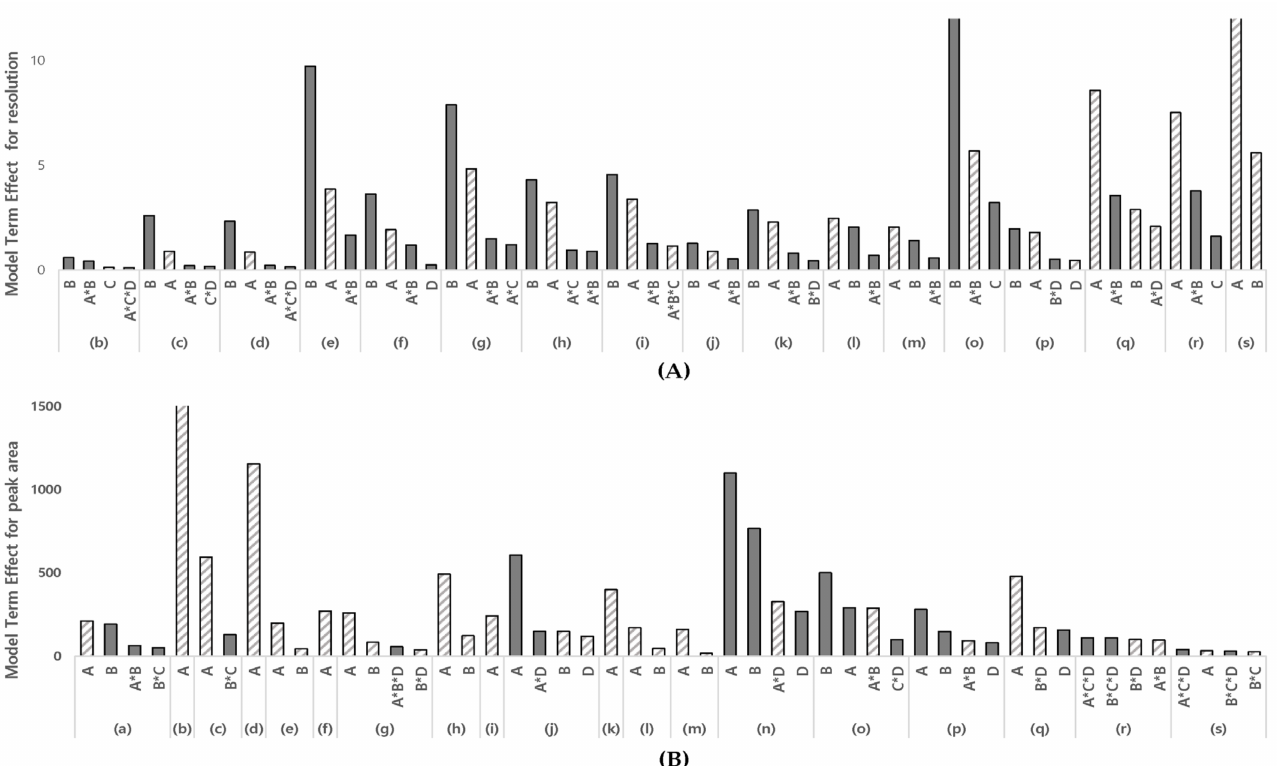
Figure 3. Model terms ranking the Pareto charts, depicting the influences of the initial oven temp., the flow rate of the carrier gas, the oven temp. ramping rate, and the sample injector temp. ( A ) Pareto chart for resolution; ( B ) Pareto chart for peak area; ( A ) initial oven temp., ( B ) the flow rate of the carrier, C oven temp. ramping rate D sample injector temp; (a) VB, (b) 2C1P, (c) 2CP, (d) BE, (e) 2BP, (f) 3C2M1P, (g) 12DCE, (h) 2BB, (i) 12DCP, (j) 4B1B, (k) 1BB, (l) 1B2CE, (m) 11DBE, (n) 3I1P, (o) 12DBP, (p) 1B3CP, (q) DIM, (r) 13DBP, (s) 14DBB. The height of the bar is the magnitude of the corresponding model term’s effect on the response. A dashed bar corresponds to a positive effect, while a solid bar corresponds to a negative effect, and the interaction between parameters is marked with an asterisk